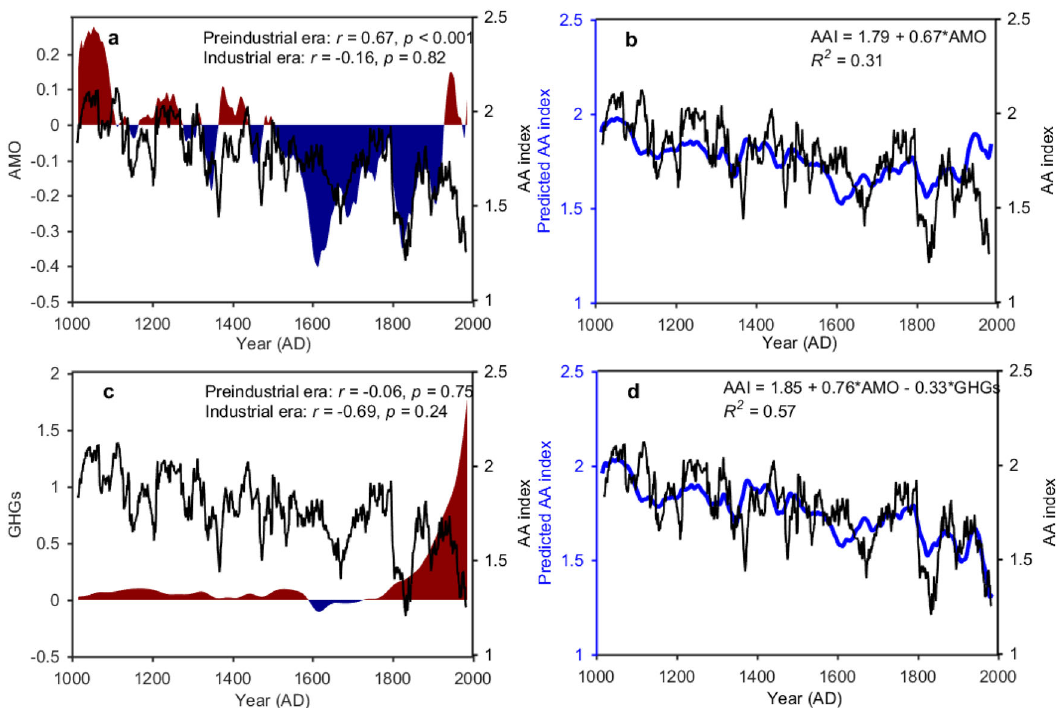
Fig. 4 Co-variations between the reconstructed millennial AA index and GHGs forcing and AMO modes. a The reconstructed millennial AA index (black line) derived from the PDA-based reconstruction and the reconstructed AMO index (shading) based on multi-type proxies 33 . b Actual AA index (black line) and predicted AA index (blue line) based on multivariate linear regressions on only the AMO index. c The reconstructed millennial AA index derived from the PDA-based reconstruction and the reconstructed GHGs forcing (shading) used in the PMIP3 last-millennium project 35 . d Actual AA index (black line) and predicted AA index (blue line) based on multivariate linear regressions on both the AMO index and GHGs forcing. The AMO index and GHGs forcing have been smoothed using 30 year rolling